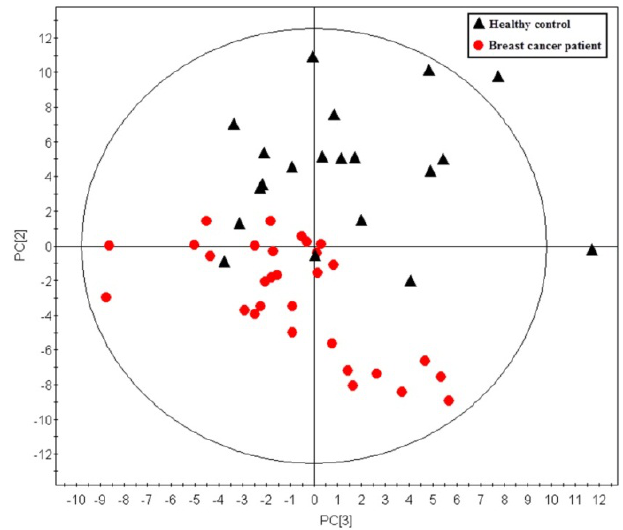
Figure 1. Principle component analysis (PCA) scores plot discriminating the metabolic profiles in plasma of breast cancer patients and those in healthy controls in the training dataset. Each red dot represents one breast cancer patient, while each black triangle represents one healthy control (five components model: R2X = 0.643, Q2 = 0.416, R2X1 = 0.261, R2X2 = 0.165, R2X3 =